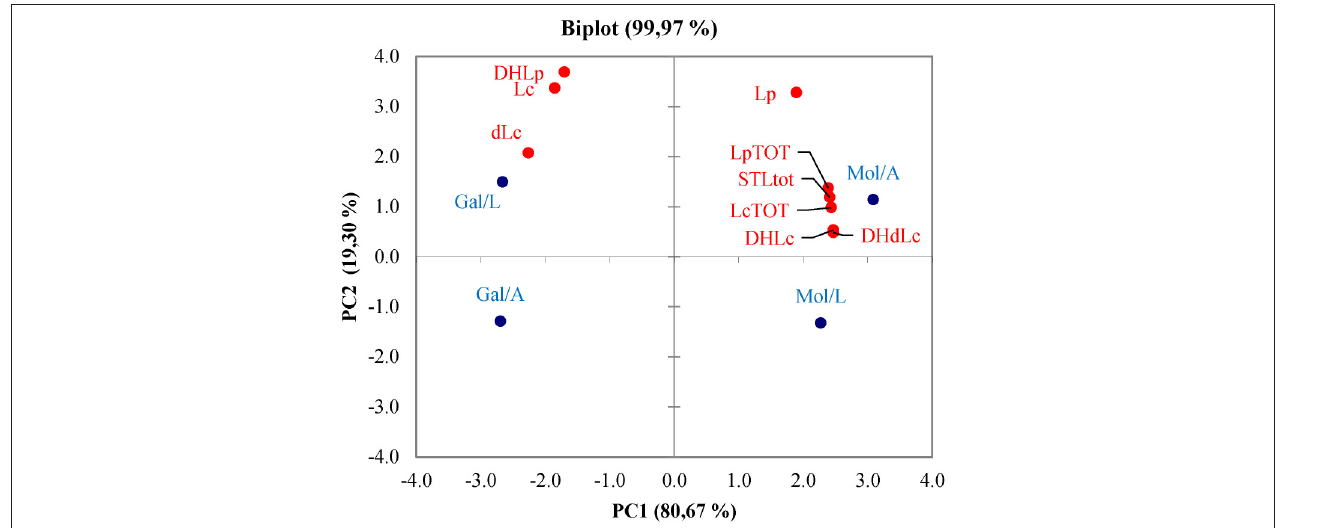
FIGURE 1 | Principal component analysis biplot showing the spatial distribution of the sesquiterpene lactones content in Mol and Gal puntarelle types cultivated in Lazio (L) and Apulia (A). Lc, lactucin; DHLc, 11(S), 13-dihydrolactucin; dLc, 8-deoxylactucin; DHdLc, 11(S), 13-dihydro-8-deoxylactucin; LcTOT, total of lactucin-like STLs; Lp, lactucopicrin; DHLp, 11(s), 13-dihydrolactucopicrin; LpTOT, total of lactucopicrin-like STLs; STLs, total STL content.